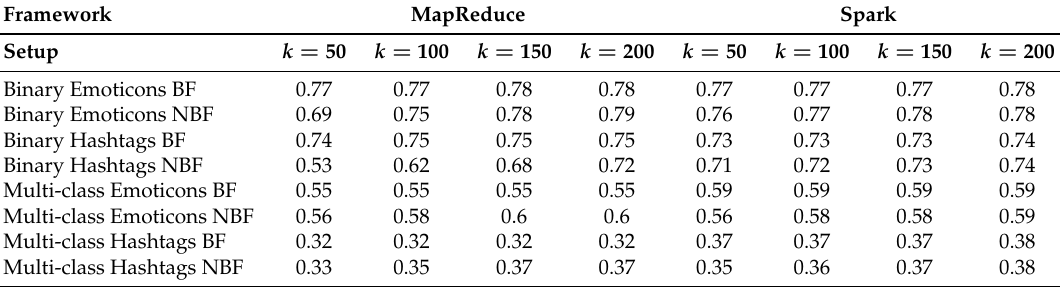
Table 4. Effect of k in classification performance (BF for Bloom filter and NBF for no Bloom filter).